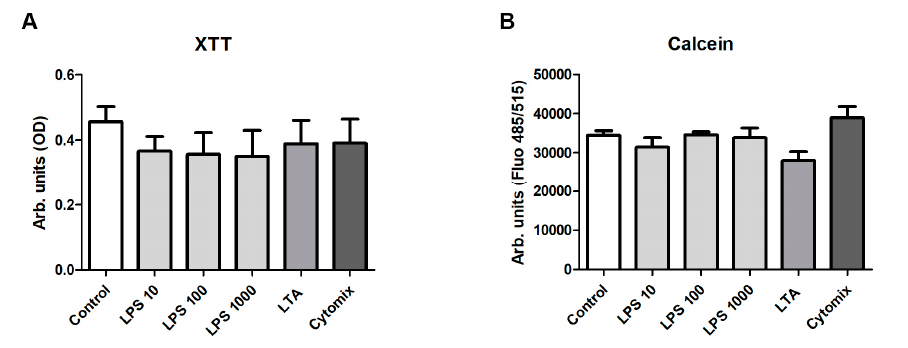
Figure 5. Cell viability after stimulation with LPS, LTA or cytomix for 96 h. A total of 5000 cells